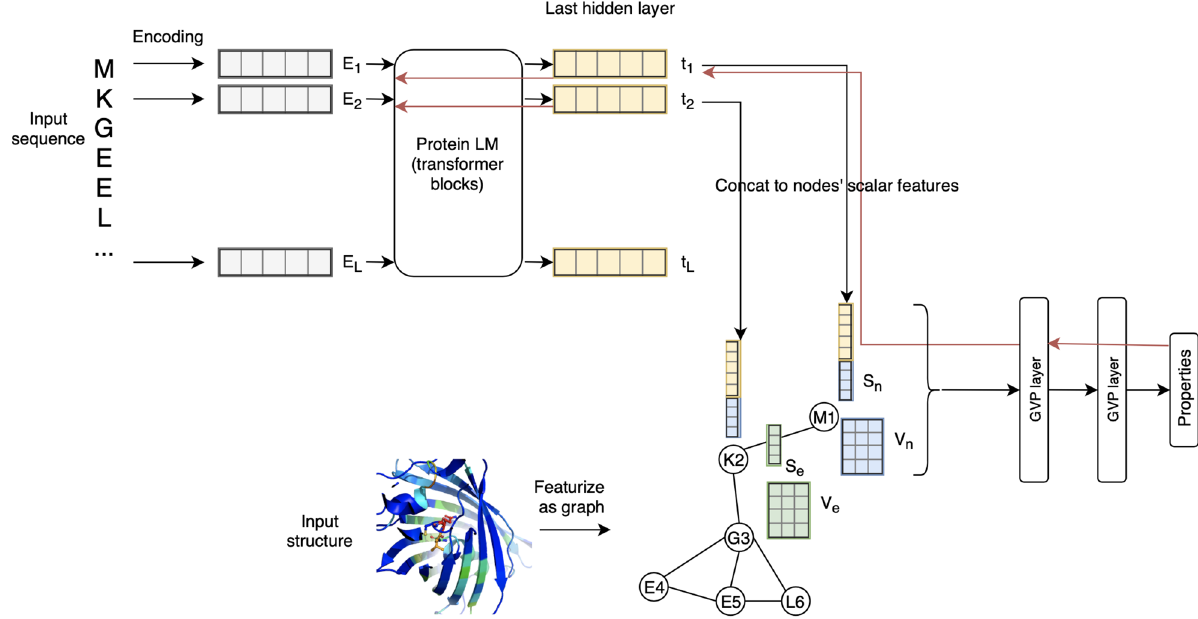
Figure 1. Schematic overview of the LM-GVP, a generalizable deep learning framework for protein property prediction from sequence and structure. LM-GVP is composed of a protein LM connecting the amino acid (AA) embeddings to a GVP network. Protein sequences are processed by the LM to calculate AA embeddings. Protein structures are first featurized to a graph of AAs, with scalar and vector features on both nodes and edges to encode information about distance and direction. The AA embeddings are concatenated with other node features on the graph, which are processed by the GVP network to learn to make predictions about protein properties. The black and red arrows indicate forward and backward passes in the network, respectively.